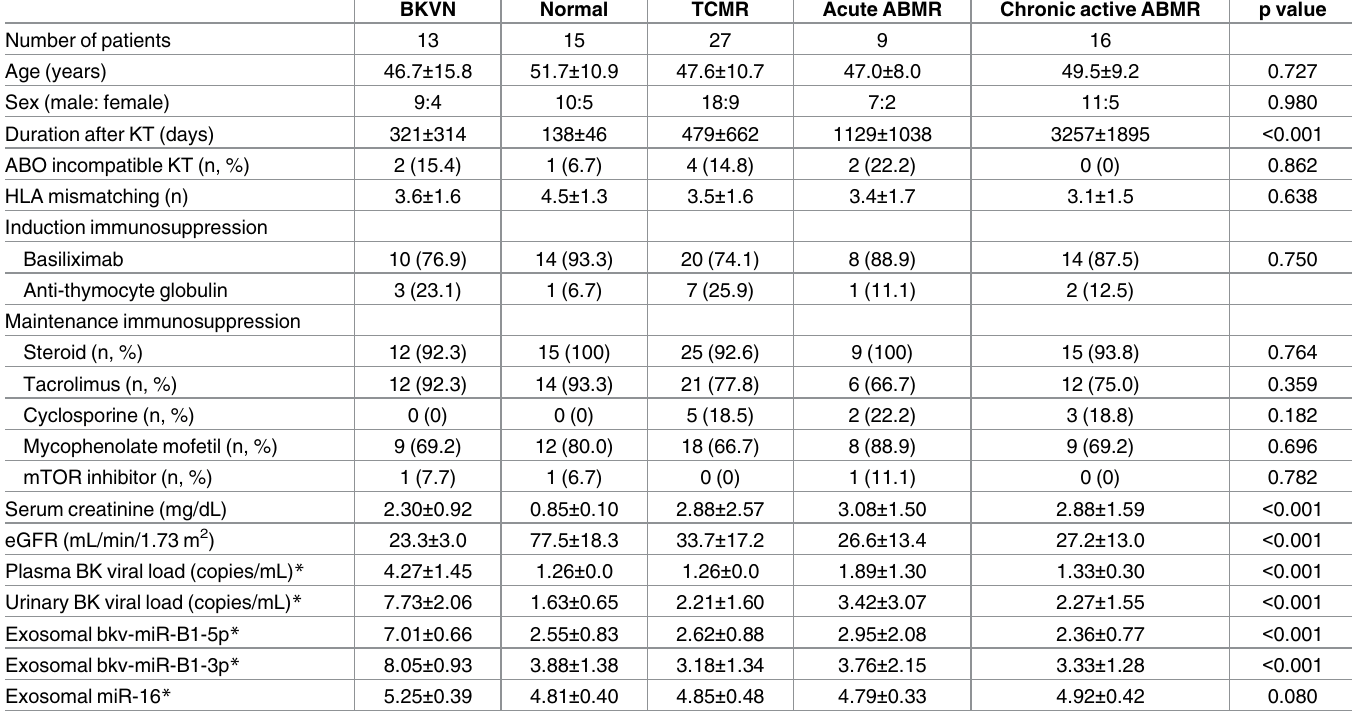
Table 2. Clinical characteristics, BK viral load and urinary exosomal BK virus microRNAin 13 patients with BKVN and 67 age, sex-matched kidney transplant recipients.